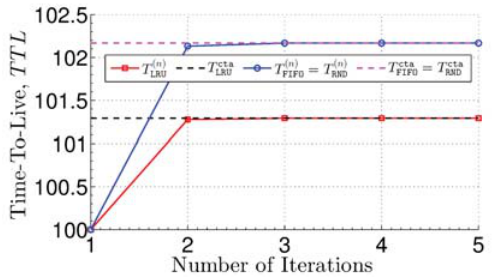
Figure 4: Approximations of TTLs T cta POLICY for LRU, RND and FIFO policies with Algorithm 1. Poisson arrivals (Λ = 1) and Zipf popularity ( α = 0 . 7). C = 100, K = 10 5 .